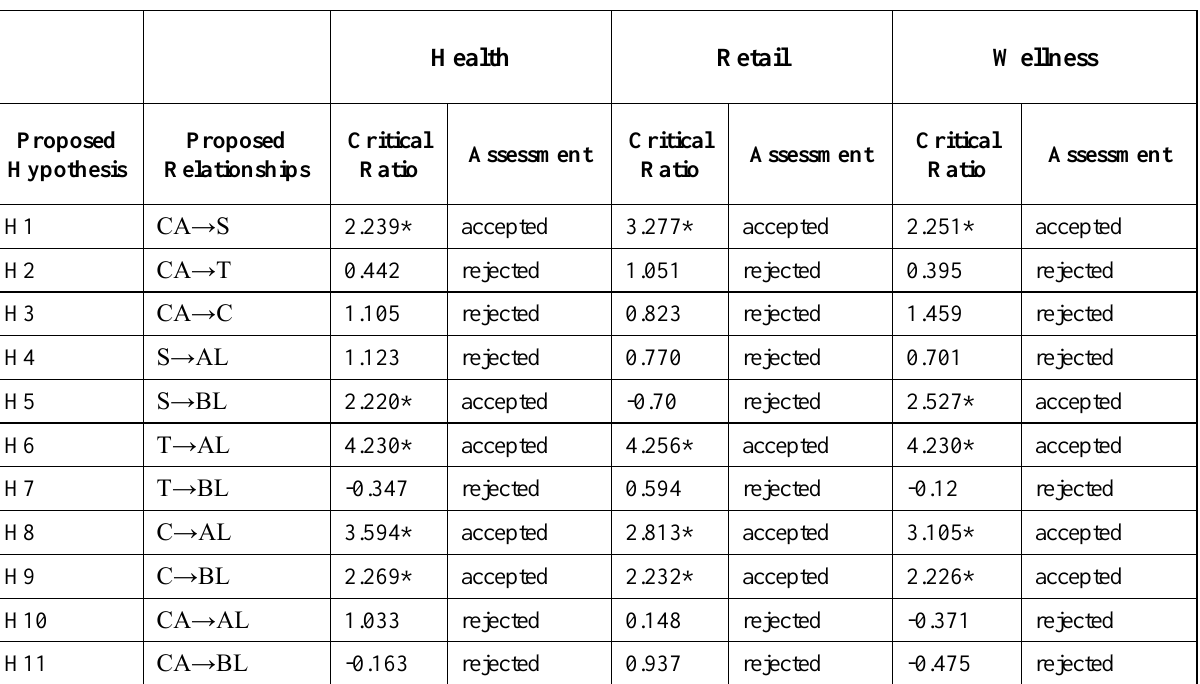
Table 05: SEM Results of Proposed Hypotheses